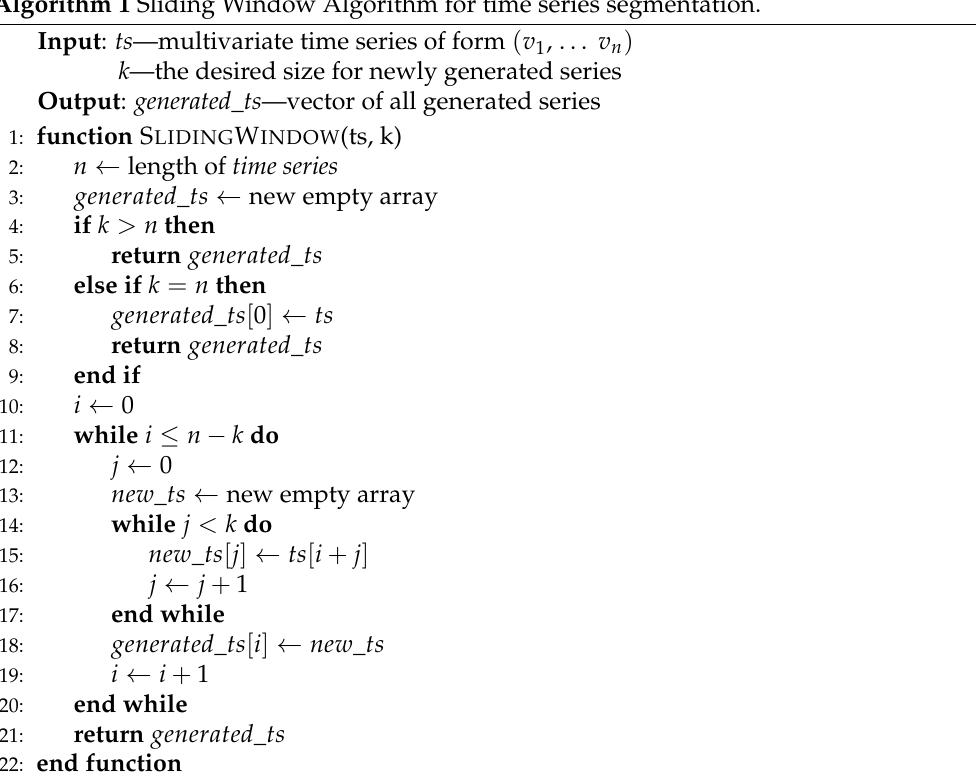
Algorithm 1 Sliding Window Algorithm for time series